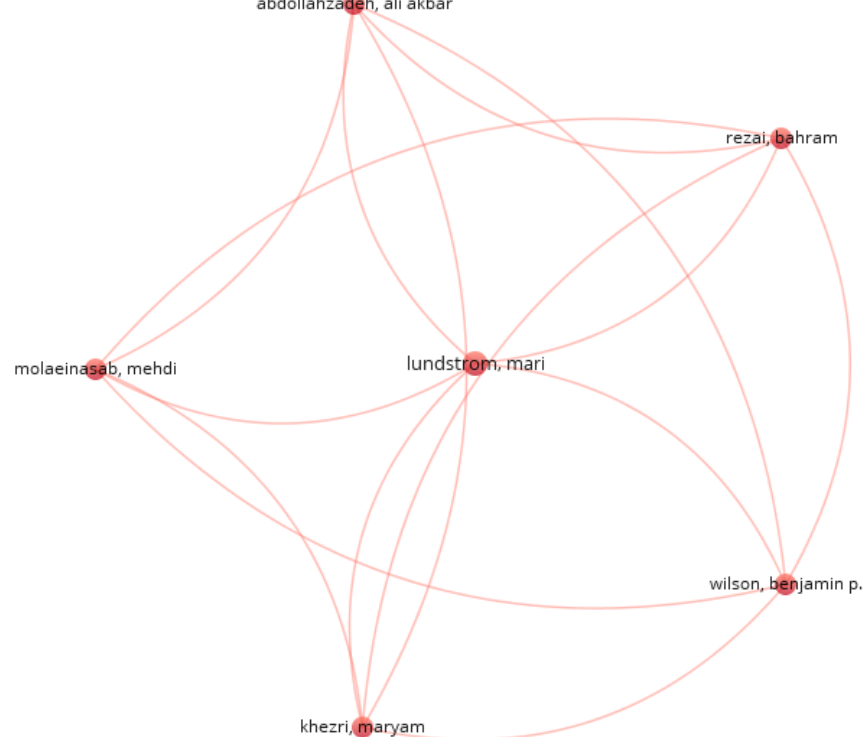
Figure 3. Relationship between authors.